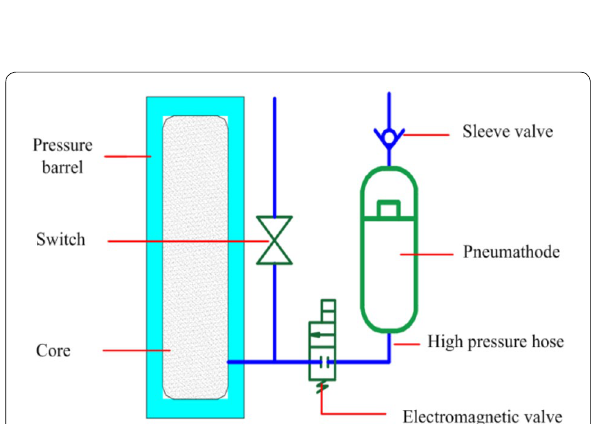
Figure 11 Schematic of active pressure-retaining technique with external accumulator